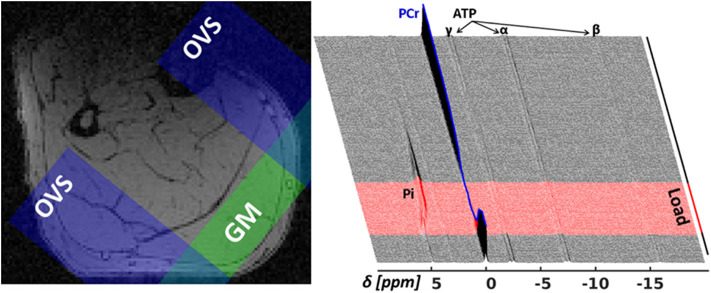
Left: Transverse T1-weighted gradient-echo image (3D T1-weighted gradient-echo MRI, TR/TE = 10/6.15 ms) with selected 31P-MRS slice in M. gastrocnemius medialis (GM, green area) and outer volume suppression bands (OVS, blue areas) selected to suppress signal contributions from adjacent tissue. Right: “Stack plot” of dynamic 31P-MR spectra series from GM muscle. The spectra acquired during the 3 min load phase (red graphs in the right chart) show rapid PCr decrease during the validation phase as well as a subsequent, significant resonance frequency shift of inorganic phosphate (Pi) due to a strong, anaerobic glycolysis related pH decrease. Please note that this paper focuses on the first steep decrease of PCr in the validation phase (t < 25 s).